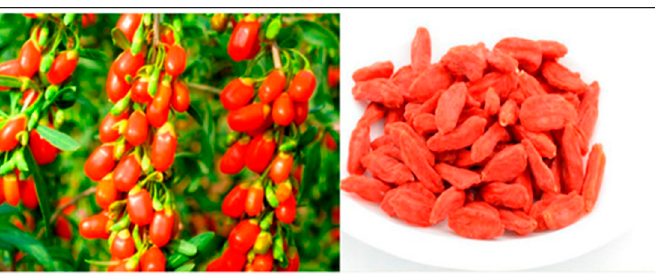
Figure 1. The fresh (left) and dried (right) berry fruits of Lycium barbarum ‘ Fructus lycii’ . F lycii is usually found in the arid and semi-arid regions of China and eastern Asia